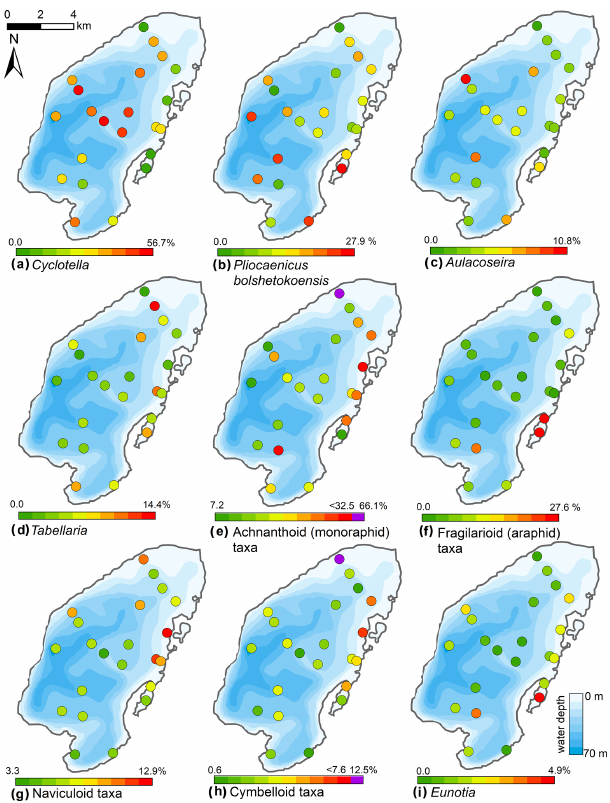
Figure 10. Spatial distribution of the main diatom taxa in the sur- face sediments of Lake Bolshoe Toko. Maps compiled in ArcGIS 10.4. Scales chosen as 10 classes with equal intervals. Maps e and h had exceptionally high values of achnanthoid and cymbelloid taxa only in the very shallow (0.5m) site PG2142. These values are shown in purple, indicated separately on the right-hand side of the scales.